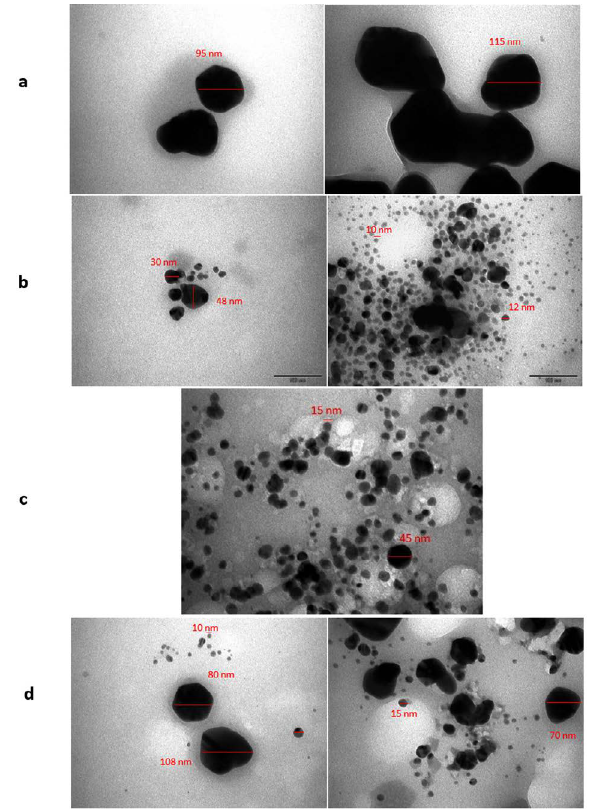
Fig 4. TEM images of a) La, b)Rh, c) Ca and d) Th silver